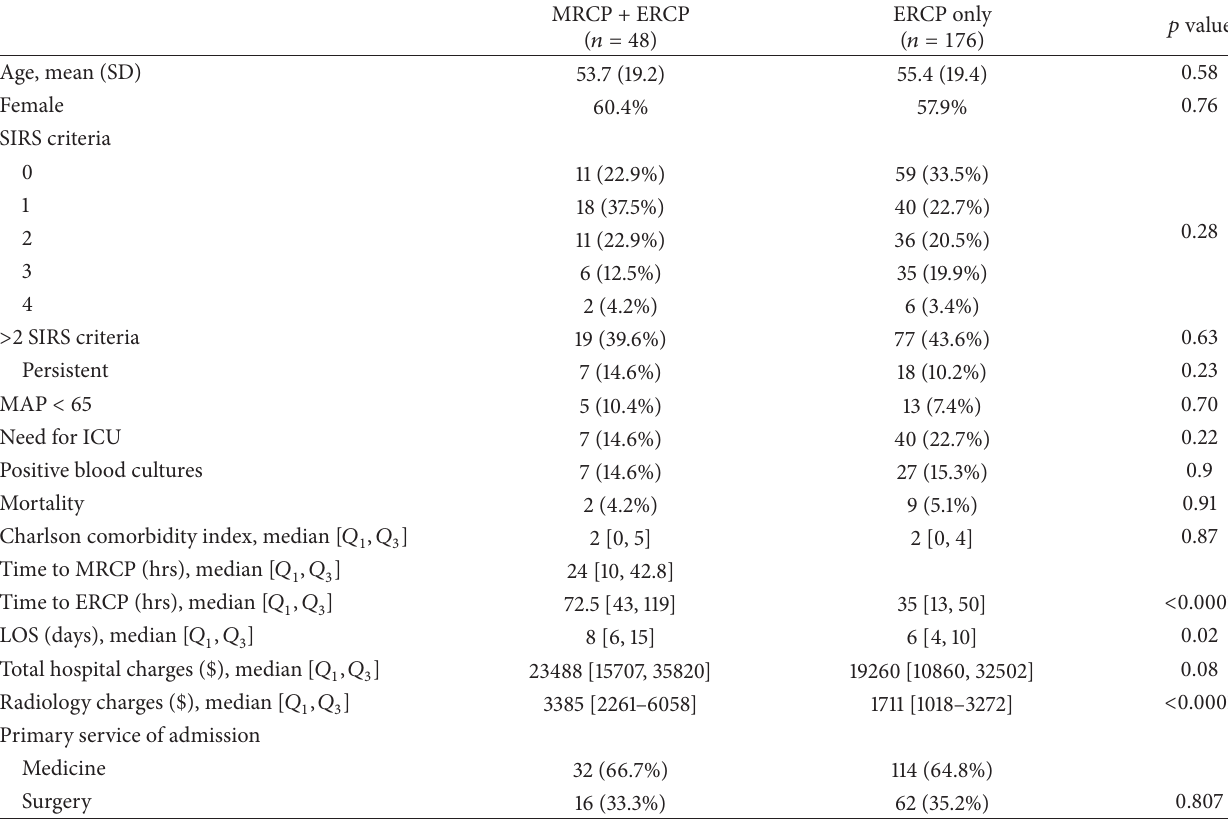
Table 1: Demographic, clinical, and cost characteristics of patients at high risk of choledocholithiasis.